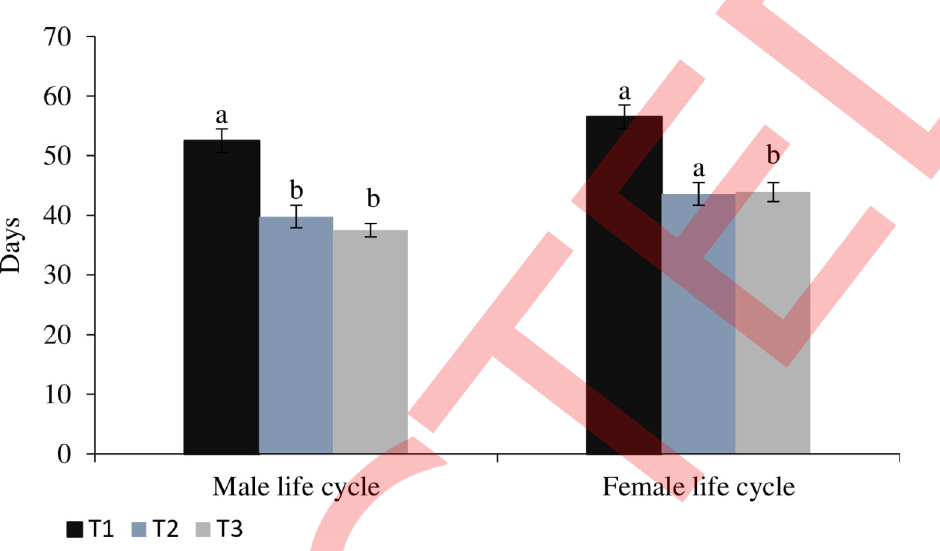
Fig 8. Total life span (mean ± SE) of male and female P . gossypiella on wheat germ, okra and chickpea diet. The means represent by bar gram by same letters are not significantly different at p > 0.05 by Tukey’s HSD test.